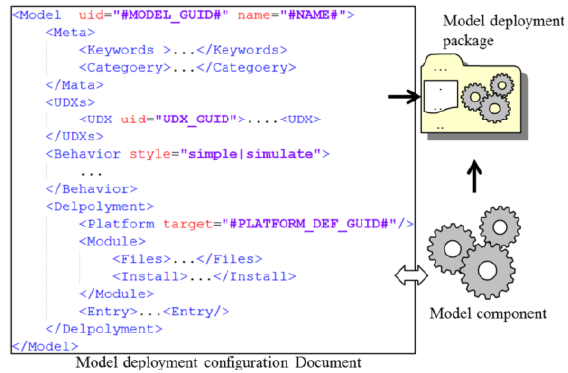
Figure 8 The Model Description